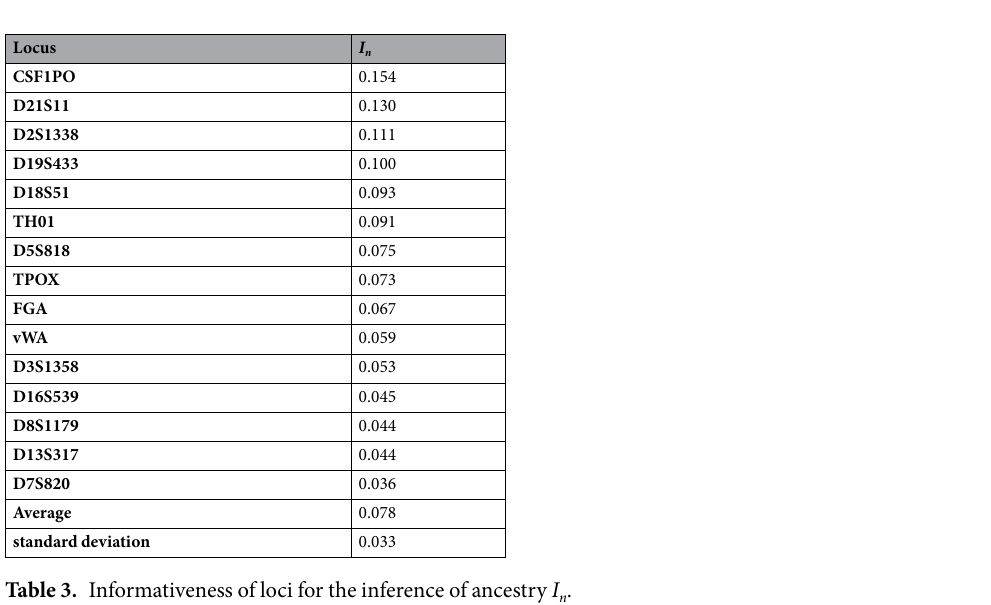
Table 3. Informativeness of loci for the inference of ancestry I n